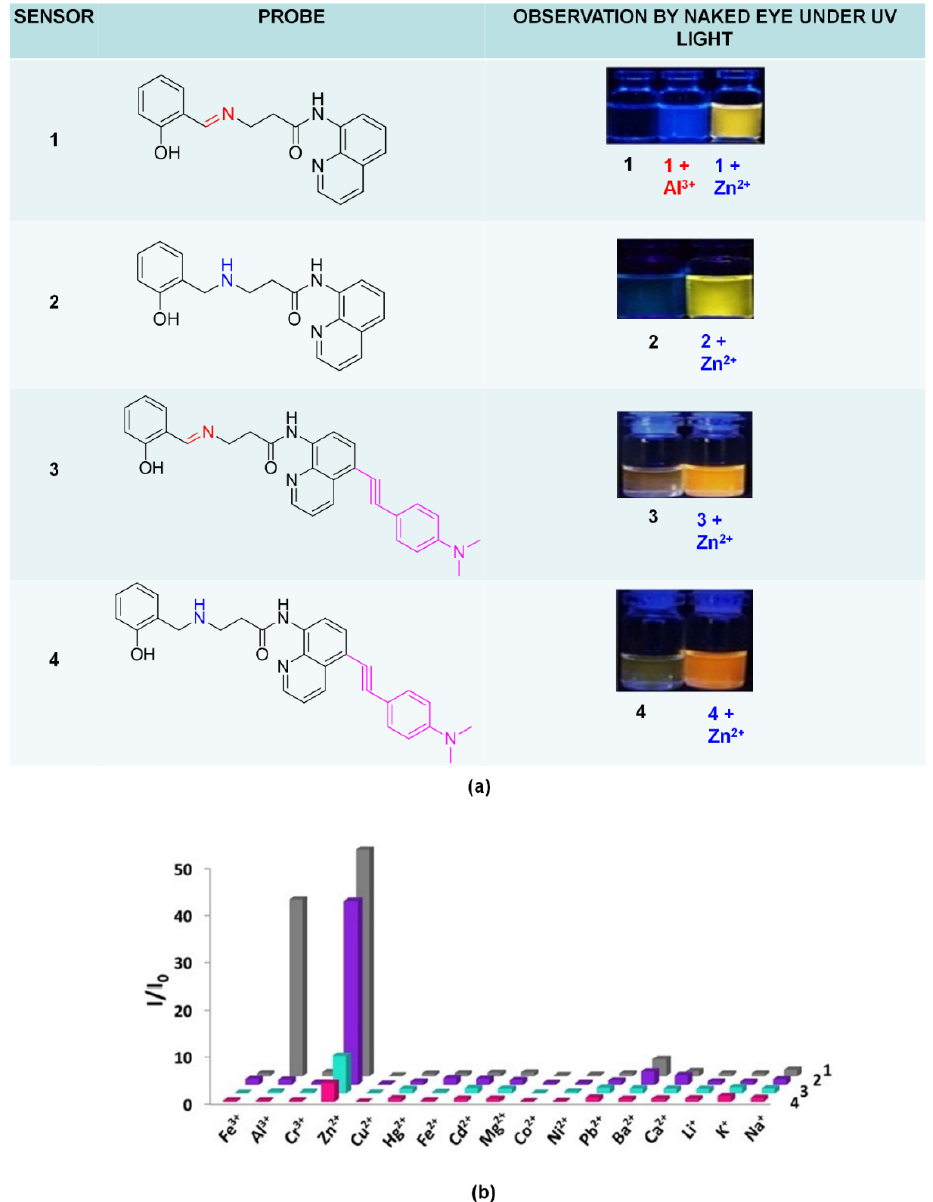
Figure 15. ( a ) Structure of four sensors and observation of color changes before and after reaction with metal ions. ( b ) Fluorescence enhancement ratios of sensors 1 to 4 in 9 EtOH: 1 H 2 O in the presence of different metal ions at excitation 360 nm and emission 420 nm (200 mM).